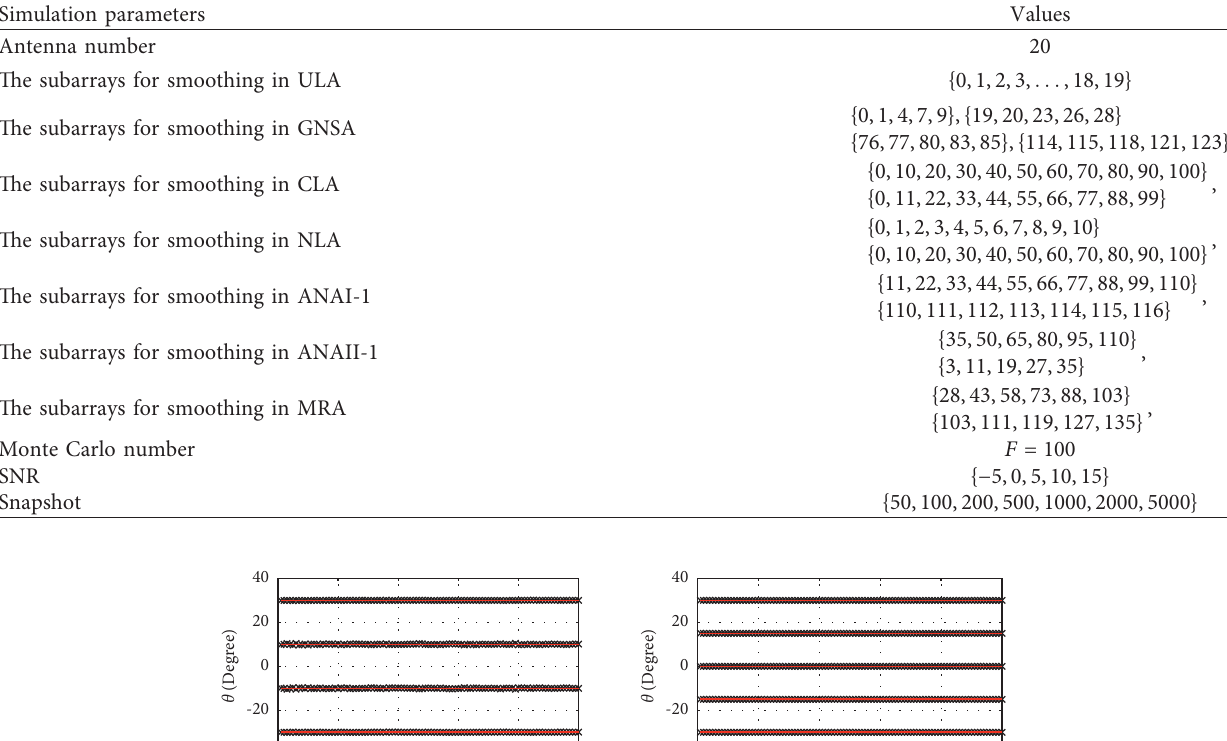
Table 4: Simulation conditions for the